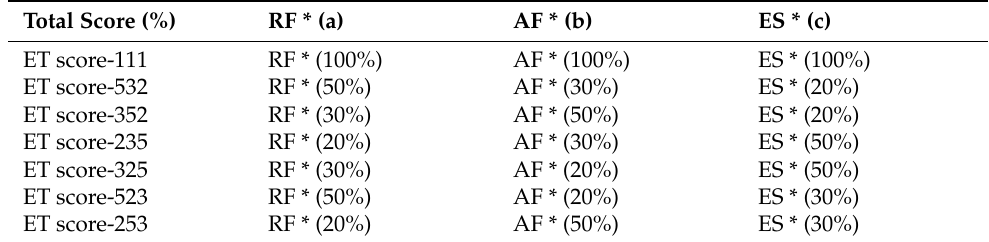
Table 6. Sensitivity parameters for different weight percentages in the ET